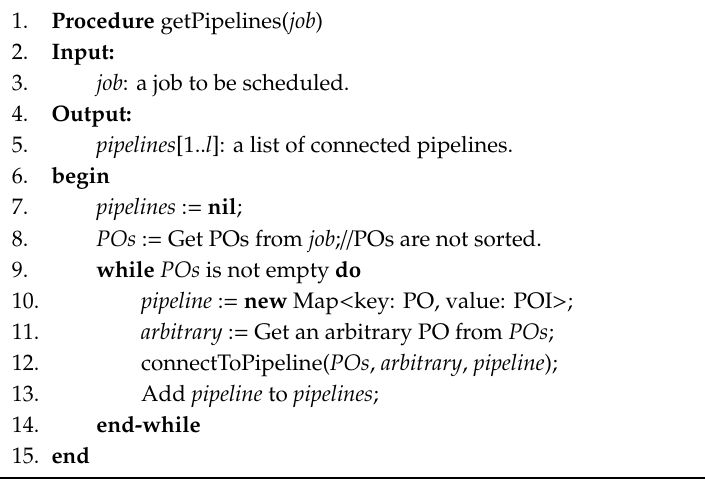
Algorithm 3 Procedure getPipelines() to extract pipelines from a job